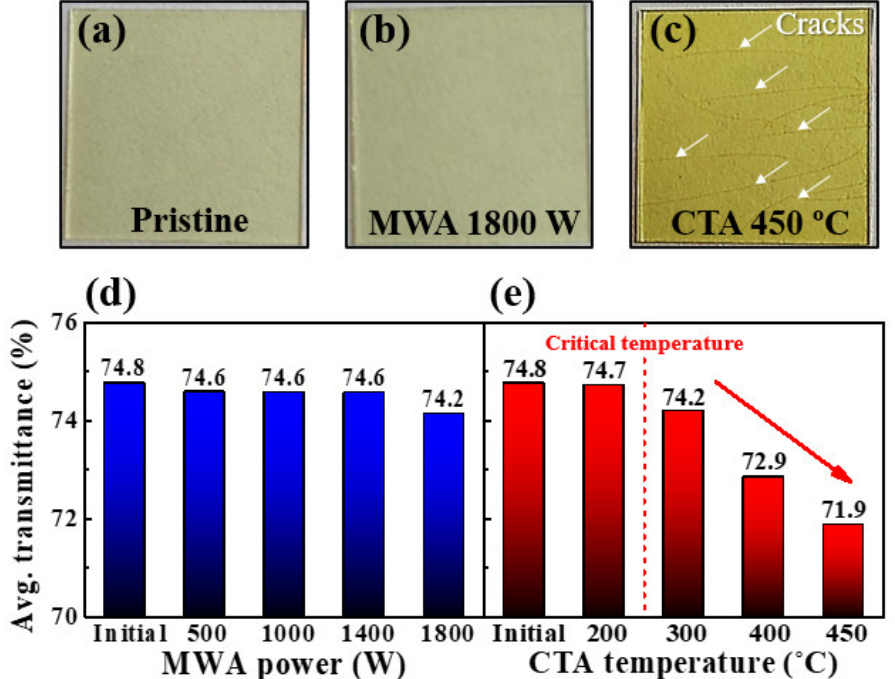
Figure 3. Photographs of thermal damage to the PI substrates during the annealing processes: ( a ) pristine, ( b ) MWA 1800 W, and ( c ) CTA 450 °C. Average transmittance in visible light (380–800 nm) as a function of ( d ) MWA power and ( e ) CTA temperature.